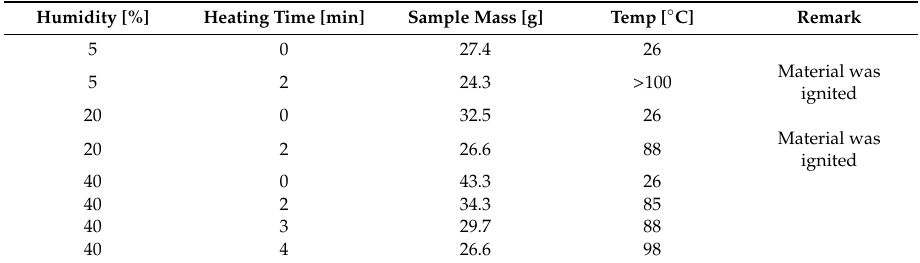
Table 3. Heating of granules (ODTMA–clay) which included di ff erent water percentages in a MW oven (700 W) for several durations: removal of water and elevation of temperature of granules a